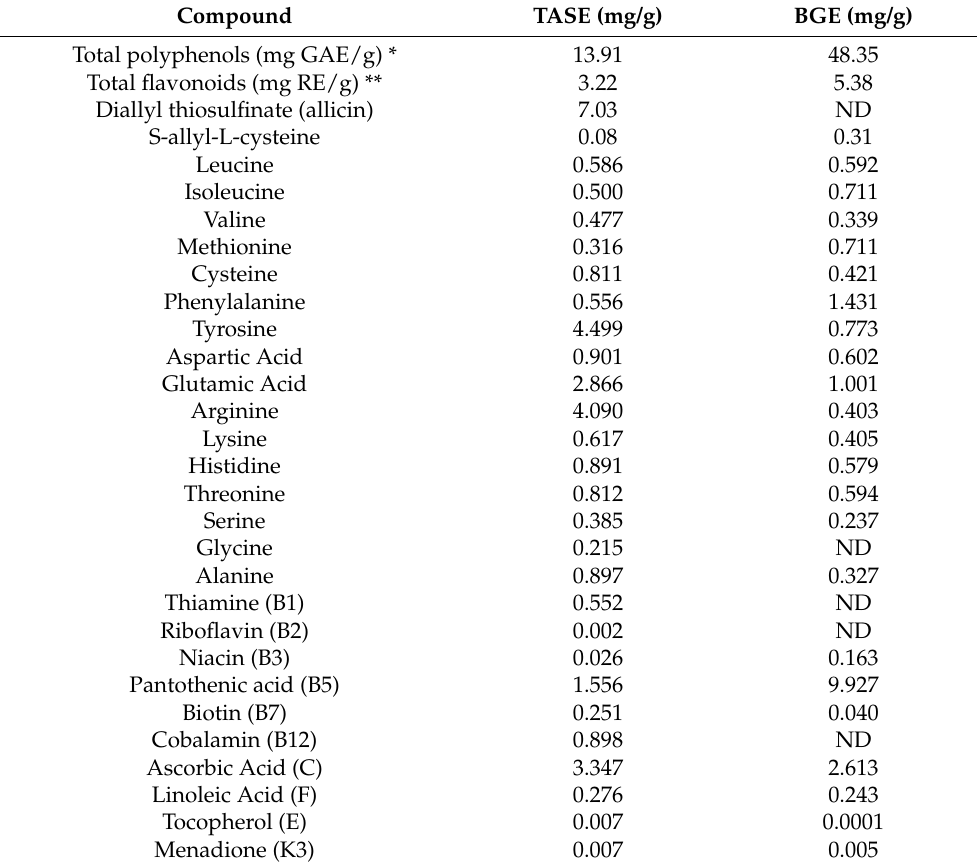
Table 1. Composition of organic compounds of lyophilized thiosulfinate-enriched Allium sativum extract (TASE) and black garlic extract (BGE) from purple garlic of Las Pedroñeras (Cuenca, Spain) used in this